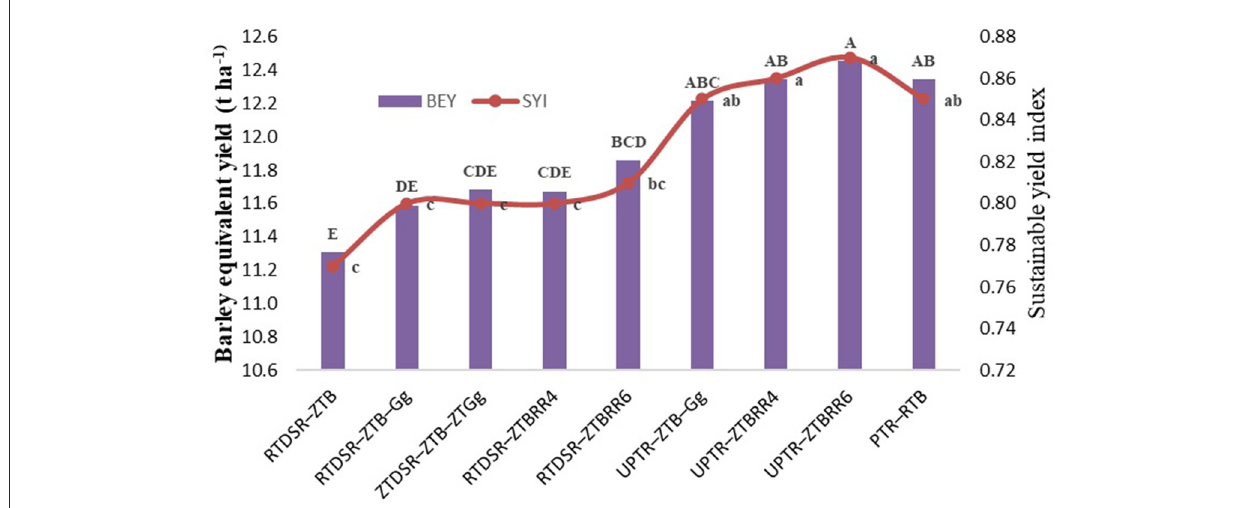
FIGURE2 Effect of tillage and residue management practices on system productivity and SYI. RTDSR–ZTB, reduced till direct seeded rice–zero till barley; RTDSR–ZTB–Gg, reduced till direct seeded rice–zero till barley–green gram; ZTDSR–ZTB–ZTGg, zero till direct seeded rice–zero till barley–zero till green gram; RTDSR–ZTB RR4 , reduced till–direct seeded rice–zero till barley + rice residue at 4 t/ha; RTDSR–ZTB RR6 , reduced till direct seeded rice–zero till barley + rice residue at 6 t/ha; UPTR–ZTB–Gg, un-puddled transplanted rice–zero till barley–green gram; UPTR–ZTB RR4 , un-puddled transplanted rice–zero till barley + rice residue 4 t/ha; UPTR–ZTB RR6 , un-puddled transplanted rice–zero till barley + rice residue 6 t/ha; PTR–RTB, puddled transplanted rice-reduced till barley; R, residue. Bars with different capital letters for BEY and small letters for SYI are significantly different ( p < 0.05) using DUNCAN’s multiple range test.